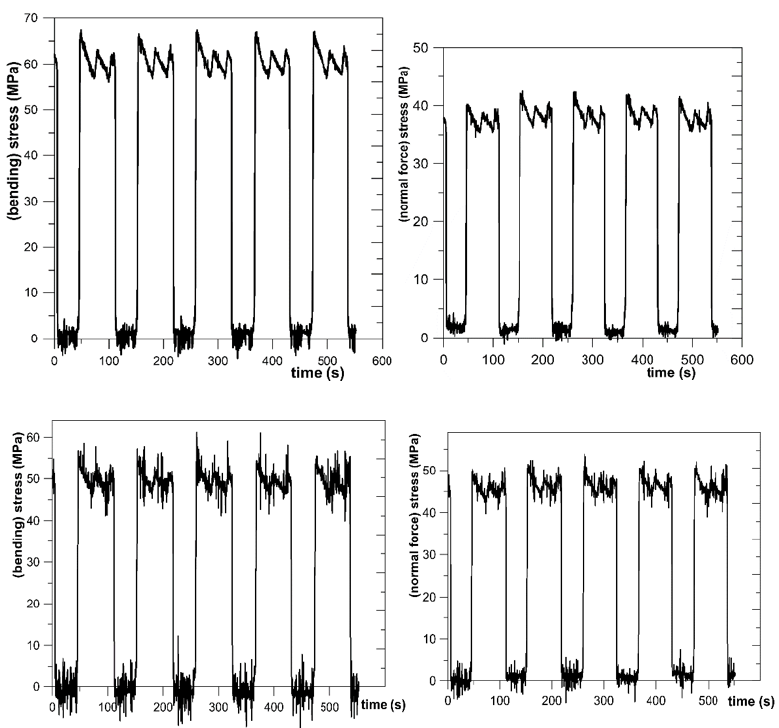
Figure 6. Diagrams of maximum normal stresses from bending moment and stress from normal force measured for two operational modes (mode 1—top, mode 2—bottom).